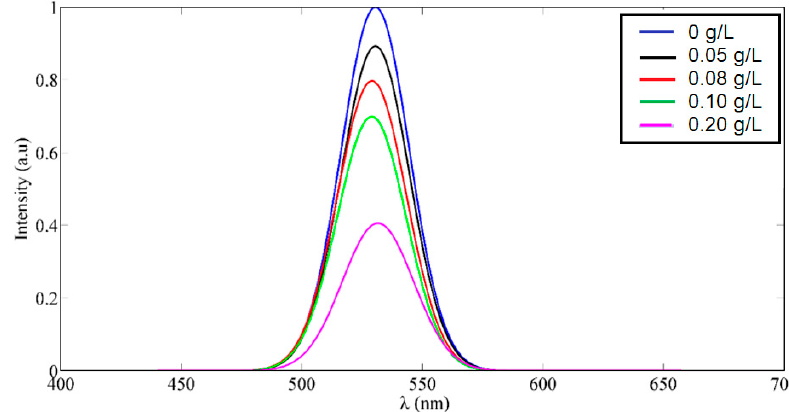
Figure 5. Fluorescence intensity quenching of in-situ gold-ceria NPs due to increasing iron particle concentrations “in g/L”.